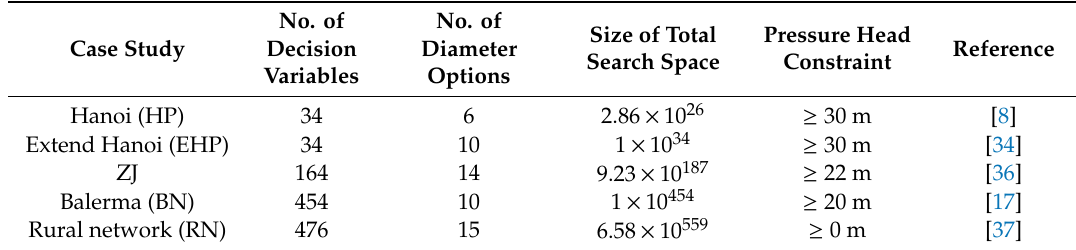
Table 2. Details of the five case